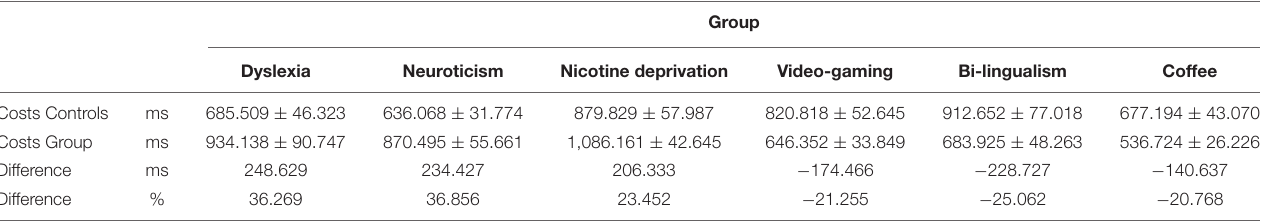
TABLE 3 | Multitasking costs (dual-task RT2—single-task RT) for the control and experimental groups in Experiment Series